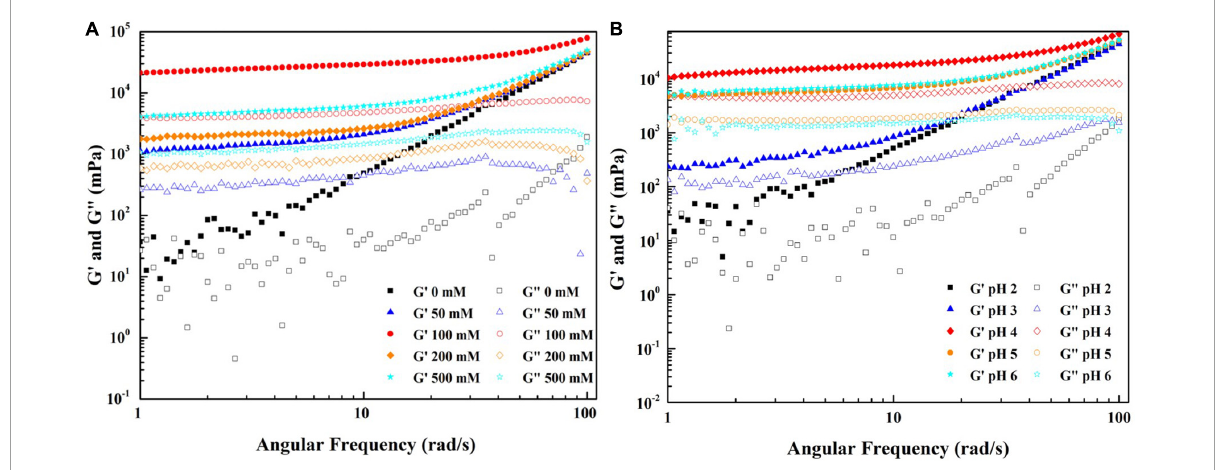
FIGURE6 Frequency sweep of WPF-GNP hydrogel (WPF: GNP = 4:1) at various NaCl concentration (0–500 mM) (A) and pH values (2.0–6.0, NaCl = 100 mM) (B)